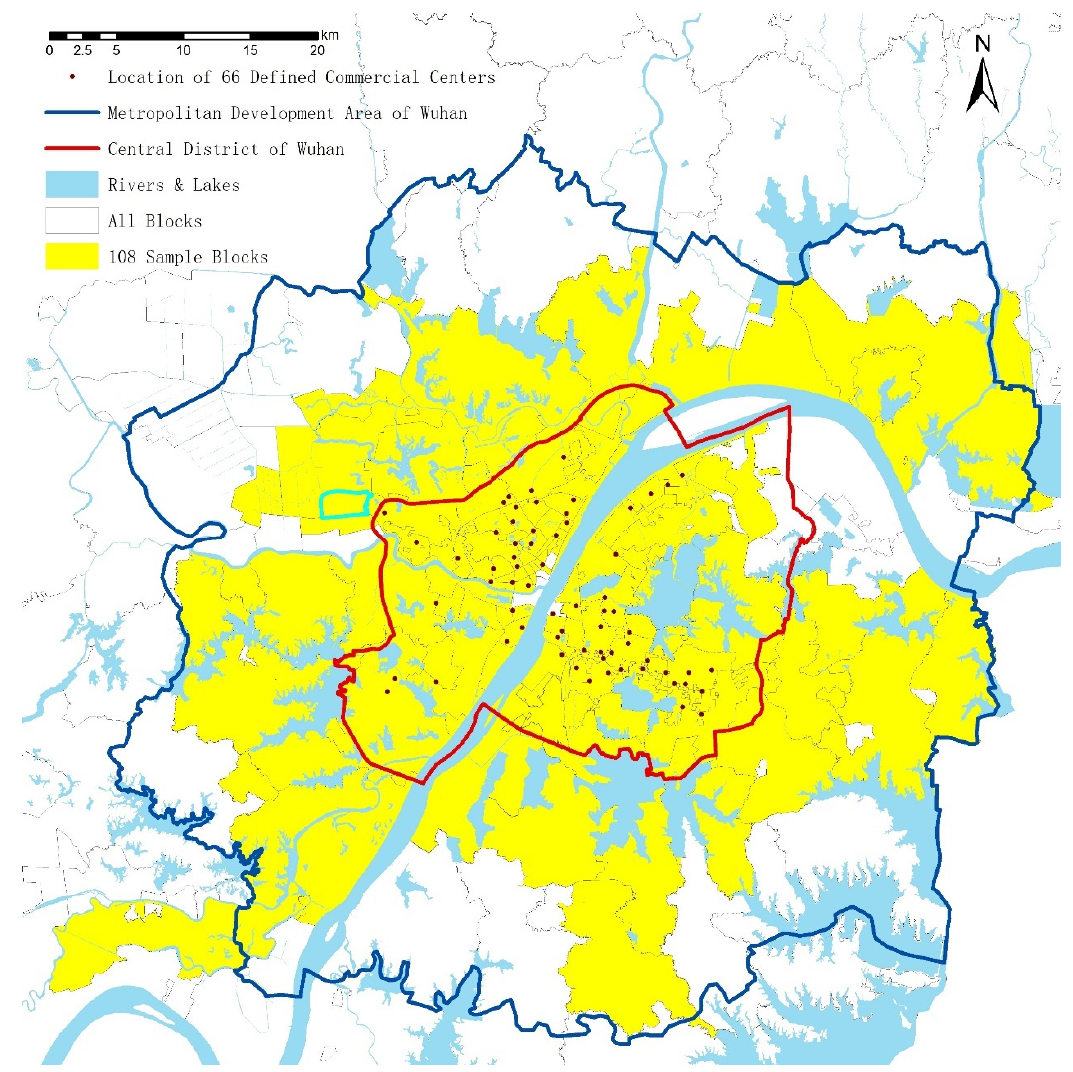
Figure 3. Spatial distribution of 108 sample blocks.